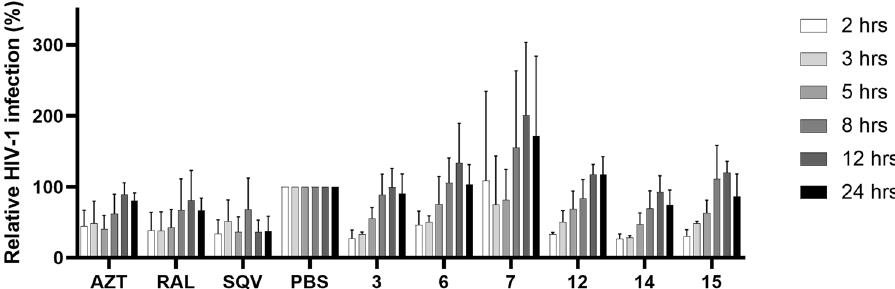
Figure 4. Modified time-of-addition assay. The panel of control compounds includes AZT (azidothymidine, an inhibitor of reverse transcriptase), RAL (raltegravir, an integrase inhibitor), SQV (saquinavir, a protease inhibitor) and PBS (phosphate-buffered saline, control). The levels of HIV-1 infection for each time point were normalized against the respective PBS control. Error bars represent standard errors from three independent